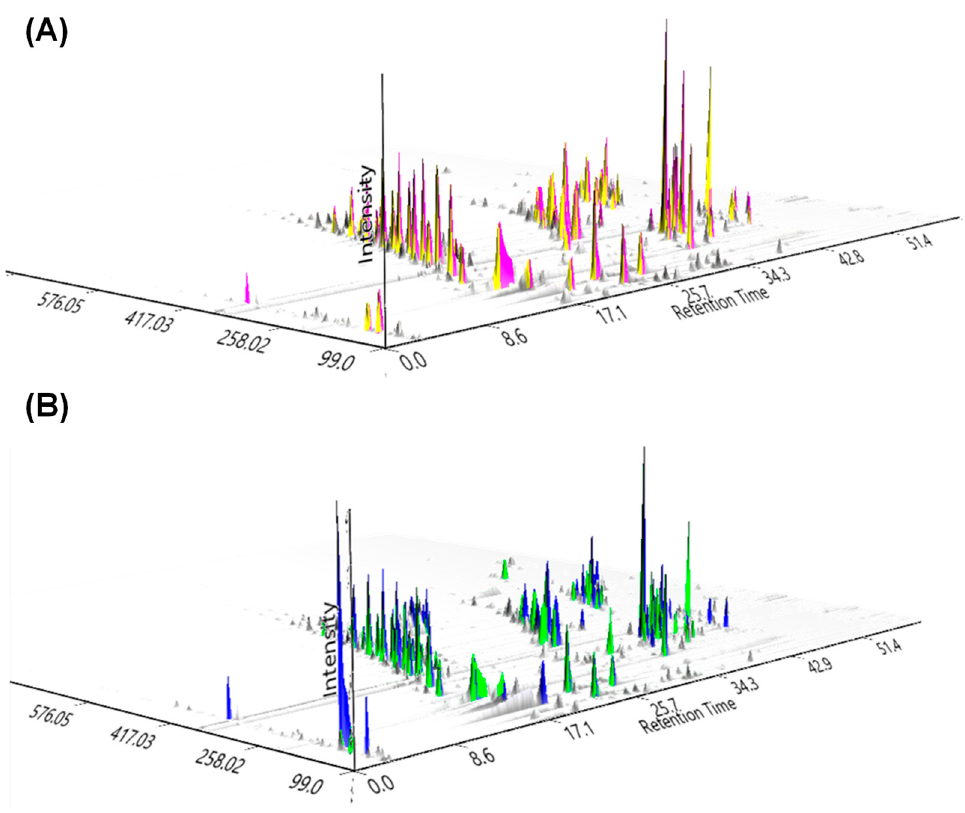
Figure 2. A 3D visualization of the chromatogram from ( A ) Cattleya fungal-infected (yellow) and healthy (pink) species; and ( B ) Vanda fungal-infected (green) and healthy (blue) species. The metabolites cinnamic alcohol (phenylpropanoid), tricin 5-glucoside (flavonoid), loliolide (terpenoid), and allobetulinol (terpenoid) were detected only in samples of healthy plants. In contrast, the metabolites 3-(4-hydroxy-3-methoxyphenyl)propyl 3-(4- hydroxyphenyl)propanoate (phenol), salidroside (phenol), isovitexin (flavonoid), rutin (flavonoid), homoorientin (flavonoid), hyperoside (flavonoid), 2,3,5,7-tetramethoxy-9,10- dihydrophenanthrene